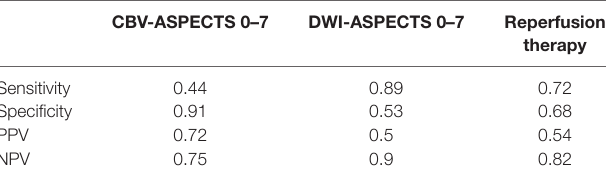
Table 4 | Sensitivity, specificity, positive, and negative predictive values for CBV and DWI-ASPECTS 0–7 and recanalization therapy for HT prediction.